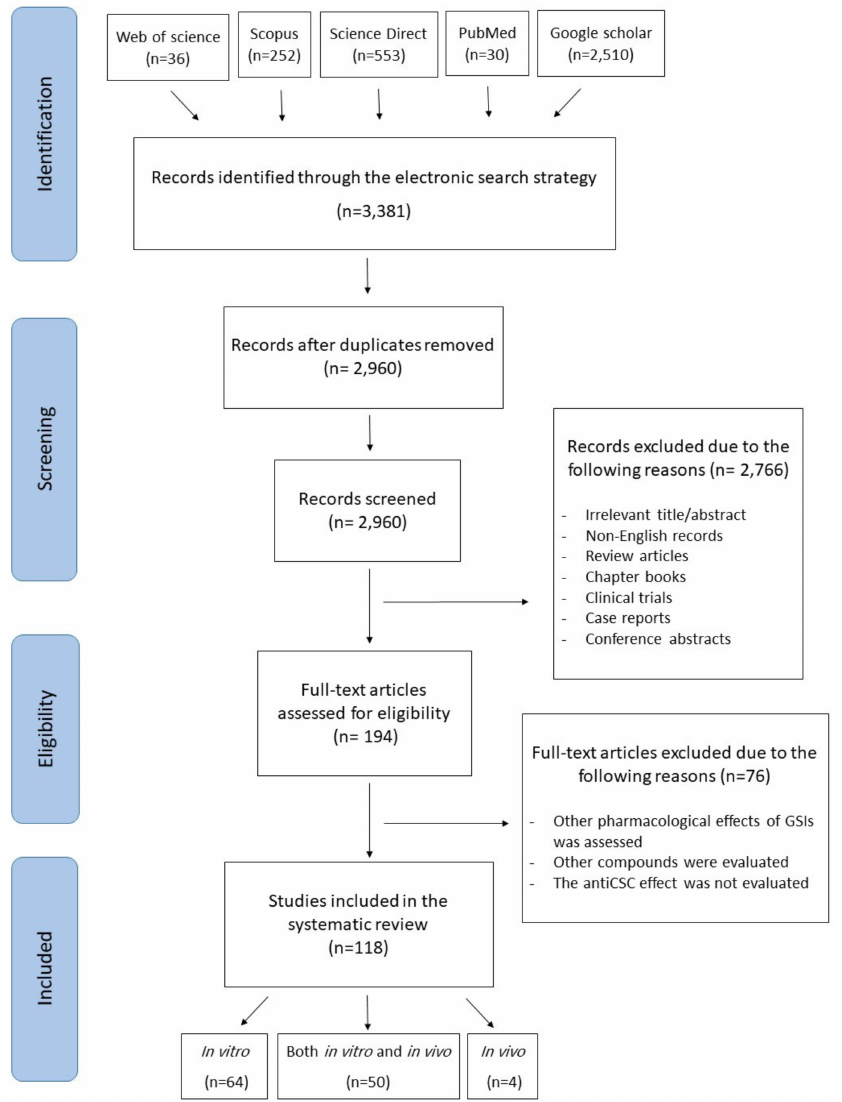
Figure 3. Chemical structure of selected γ -secretase inhibitors. Abbreviations: DAPT, ( N -[ N -(3,5- difluorophenacetyl)- L -alanyl]-S-phenylglycine t-butyl ester) and DBZ,